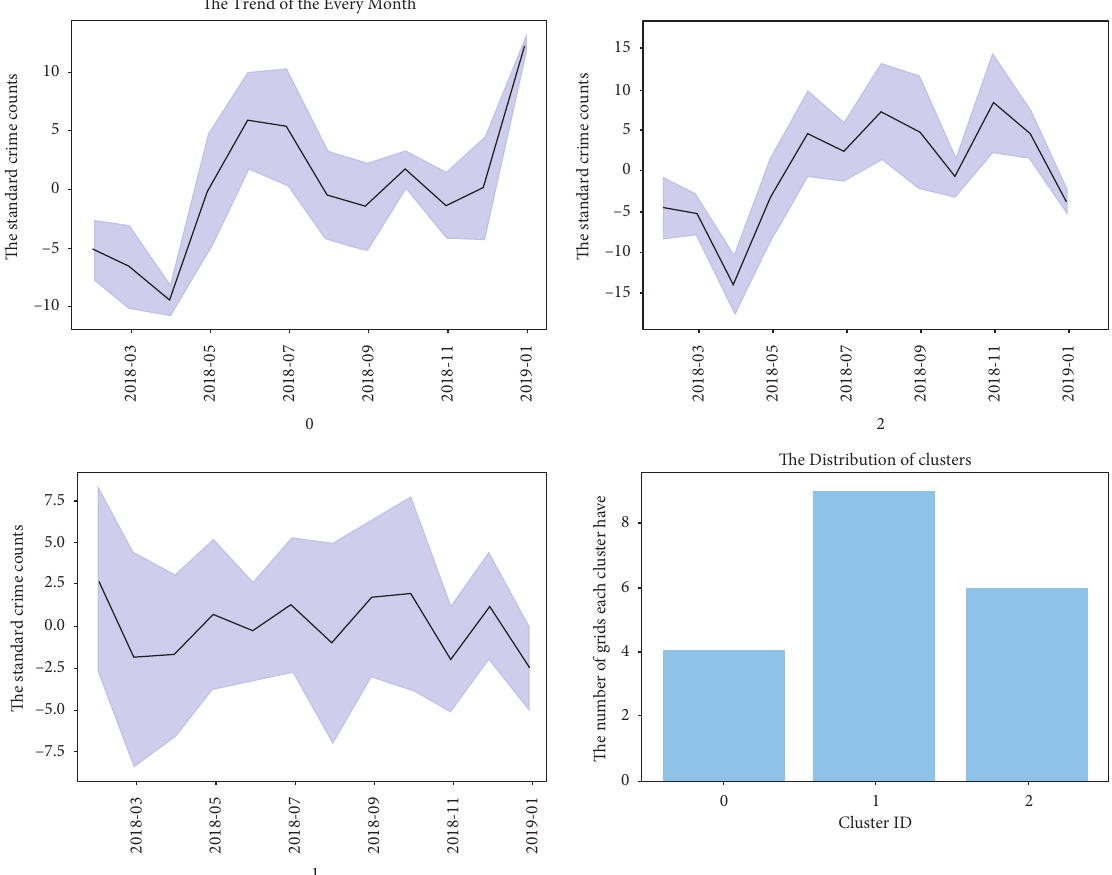
Figure 17: The burglary in Philadelphia trends in each month in 2018 and the distribution of clusters. The line charts are the monthly trends of burglary in Philadelphia in 2018. The bar chart is the distribution of the clusters.